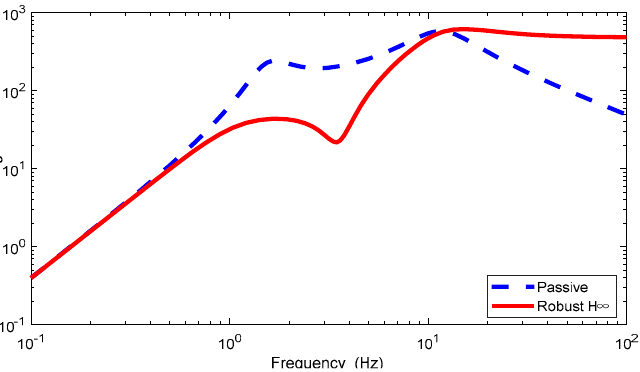
Figure 4. The frequency response of body acceleration of the closed-loop system.